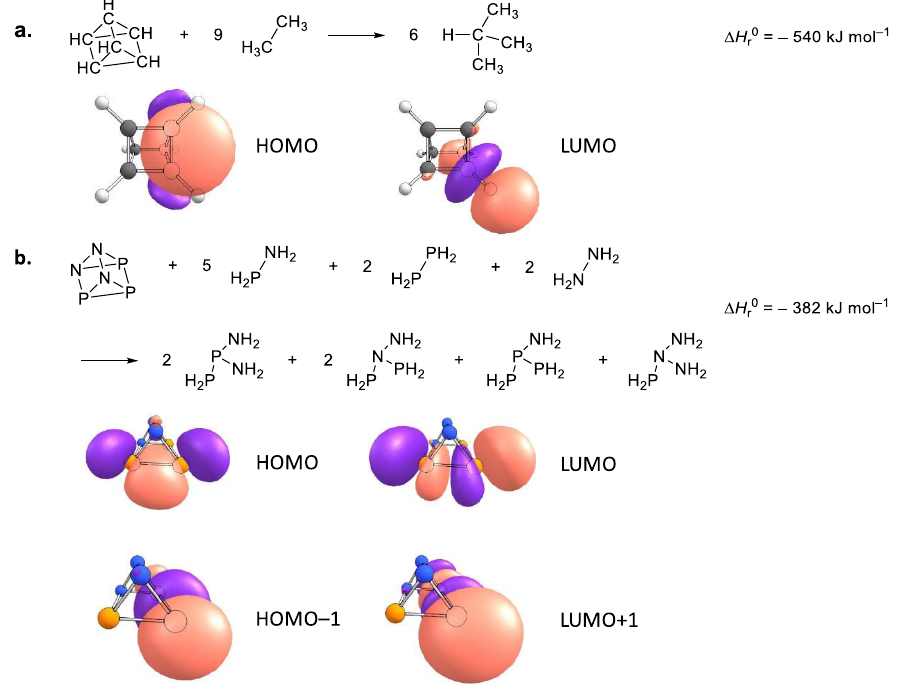
Fig. 6 Homodesmotic equations for the determination of the strain energies of prismane (C 6 H 6 , 2) and prismatic P 3 N 3 (5). The strain energies of 2 and 5 were computed at the CBS-QB3 level of theory based on the equations in ( a ) and ( b ) considering that equal numbers of C − C bonds and [P – P, P – N and N – N bonds] are broken/formed in the educts and products for 2 and 5 , respectively. Computed frontier natural bond orbitals (NBO), highest occupied molecular orbitals (HOMO), and lowest unoccupied molecular orbitals (LUMO) of 2 and 5 are also shown. Purple and light pink colors correspond to electronically rich and de fi cient circumstances, respectively. The atoms are color coded in gray (carbon), white (hydrogen), blue (nitrogen), and orange